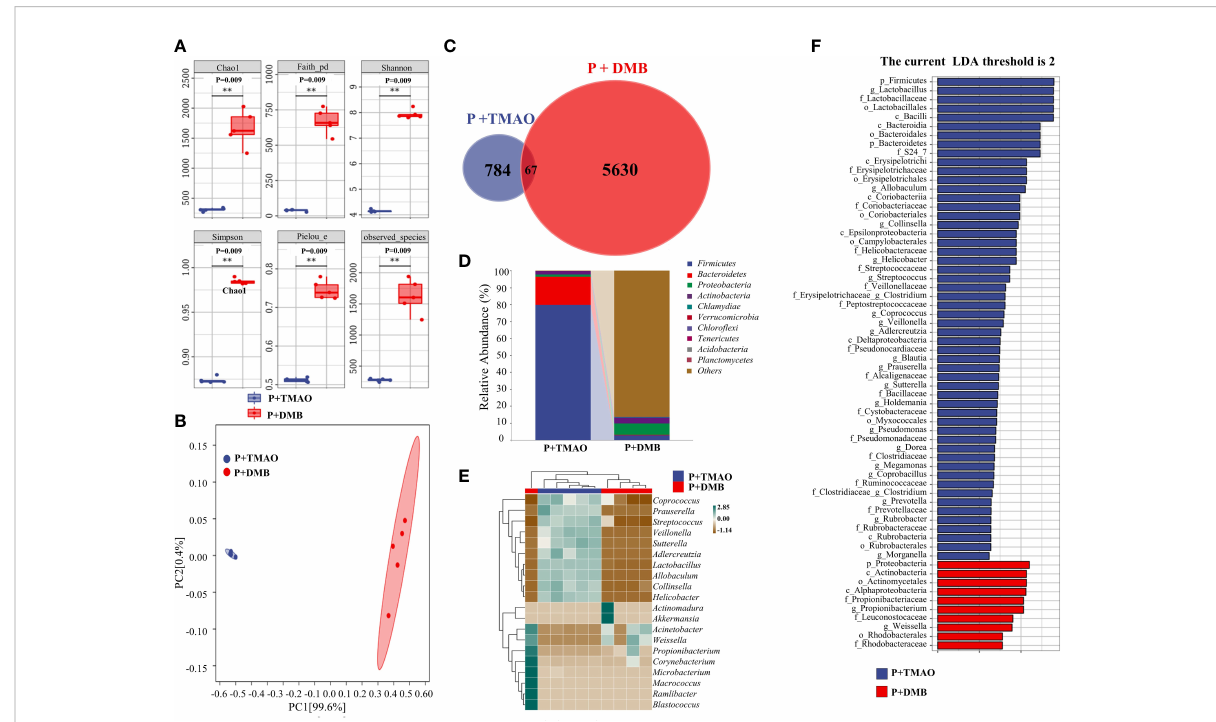
FIGURE 2 Difference of intestinal fl ora composition between the P+TMAO group and P+DMB groups. (A) The value of the indicated index of alpha diversity in the P+TMAO and P+DMB groups. The symbol ** has the meaning P ≤ 0.01. (B) PCA plot of microbial composition. (C) Venn graph based on ASV/OTU. In the fi gure, each color block represents a group, the overlapping area between the color blocks indicates the ASV/OTU shared by the corresponding group, and the number of each block indicates the number of ASV/OTU contained in the block. (D) The stack bar plot showed the composition of microbiota at the phylum level. (E) The heat map of the top 20 genera showed trends in species abundance distribution trends across samples. (F) LDA scores of intestine tissue